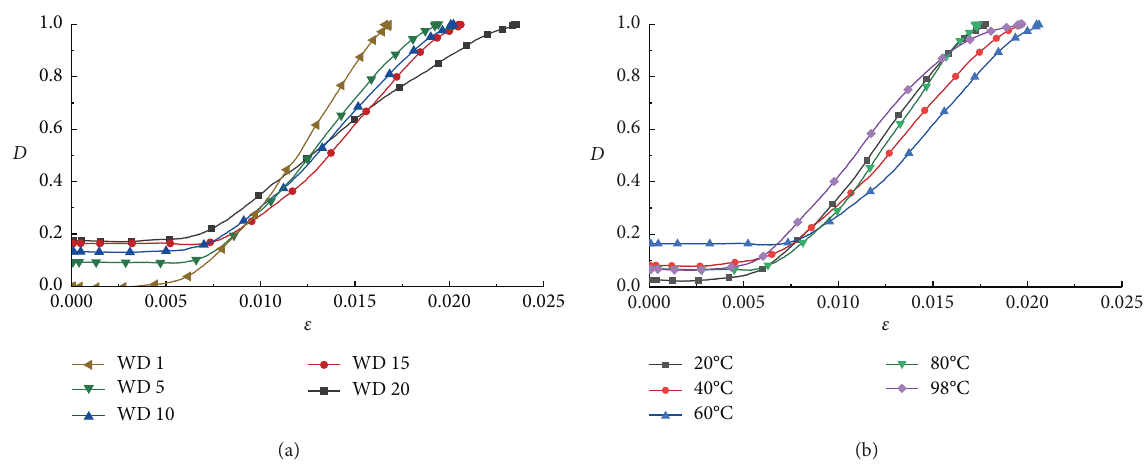
Figure 13: Coupling damage evolution during dynamic uniaxial compressive tests. (a) Coupling damage evolution after various wetting and drying cycles. (b) Coupling damage evolution under different water